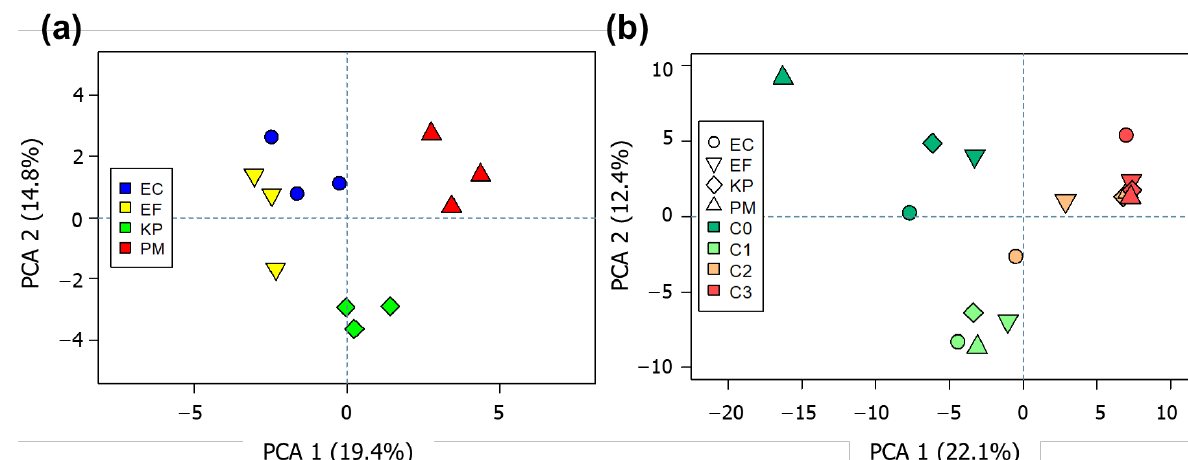
Figure 2. PCA score plots performed by using data regarding profiles obtained from ( a ) solely untreated cultures and ( b ) average of all performed assays (untreated + bio-AgNPs-treated cultures). C0 = assay without the addition of bio-AgNPs; C1, C2 and C3 = supplementation with bio-AgNPs at 12.5, 25 and 50 µg mL −1 , respectively. EC = E. coli , EF = E. faecalis , KP = K. pneumoniae , PM = P. mirabilis .